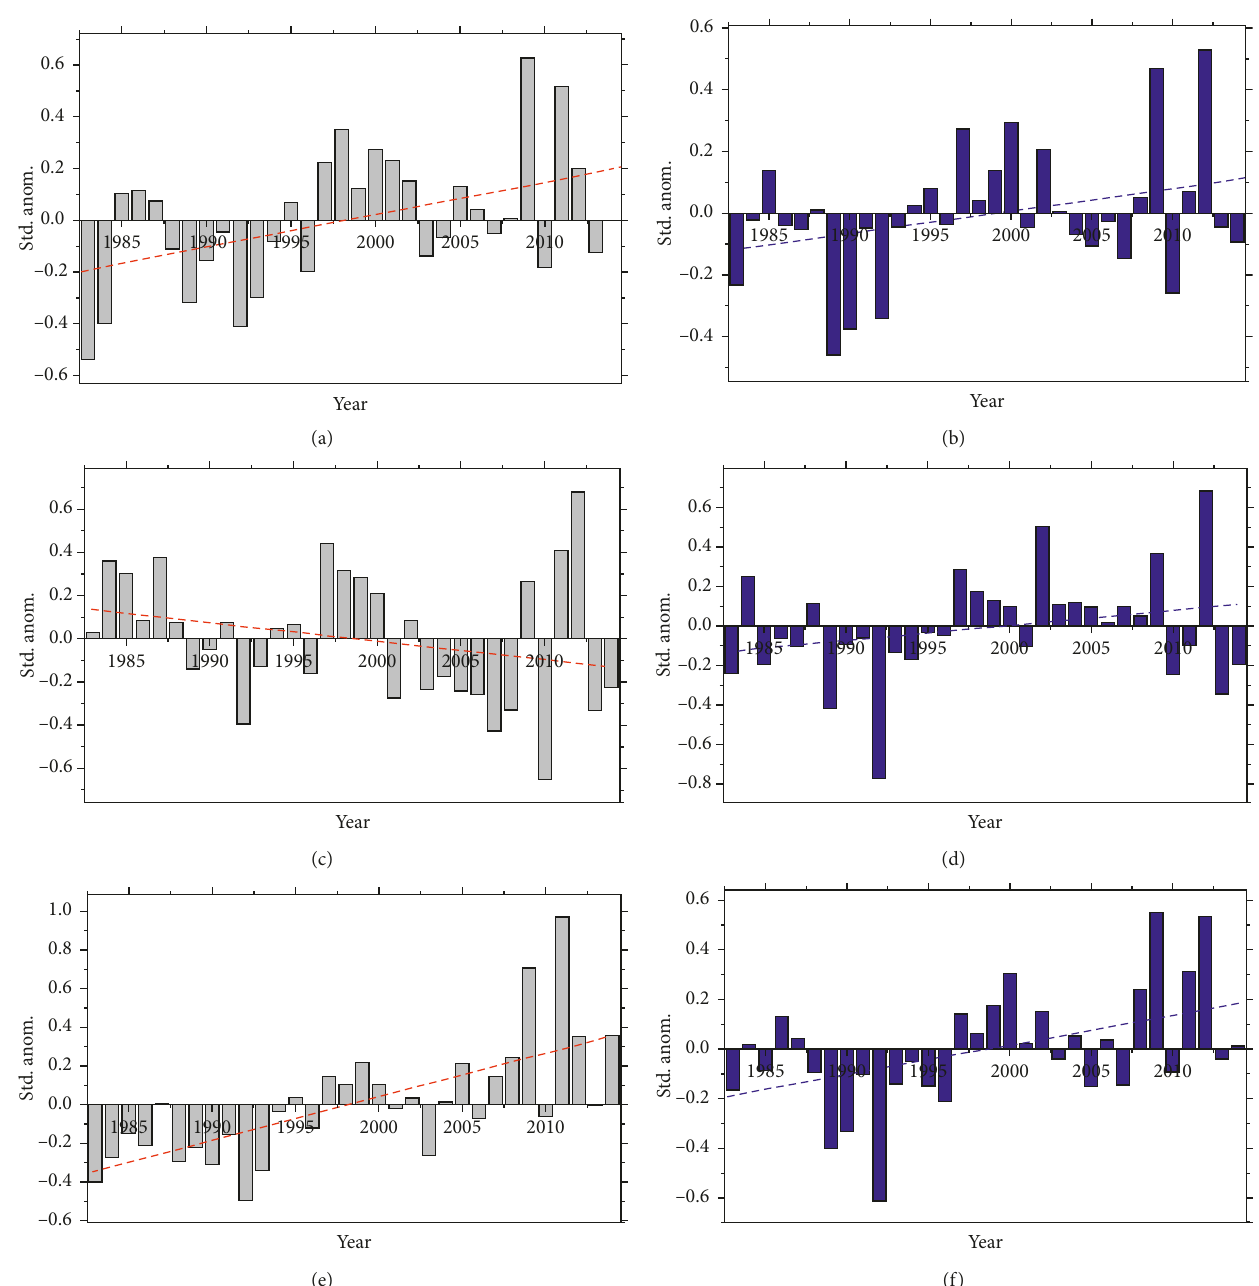
Figure 4: Standardized anomalies of the warmest day (TXx) over three agroecological zones, (a) lowland, (c) midland, and (e) highland, and for the coldest day (TXn), (b) lowland, (d) midland, and (f) highland, for the period